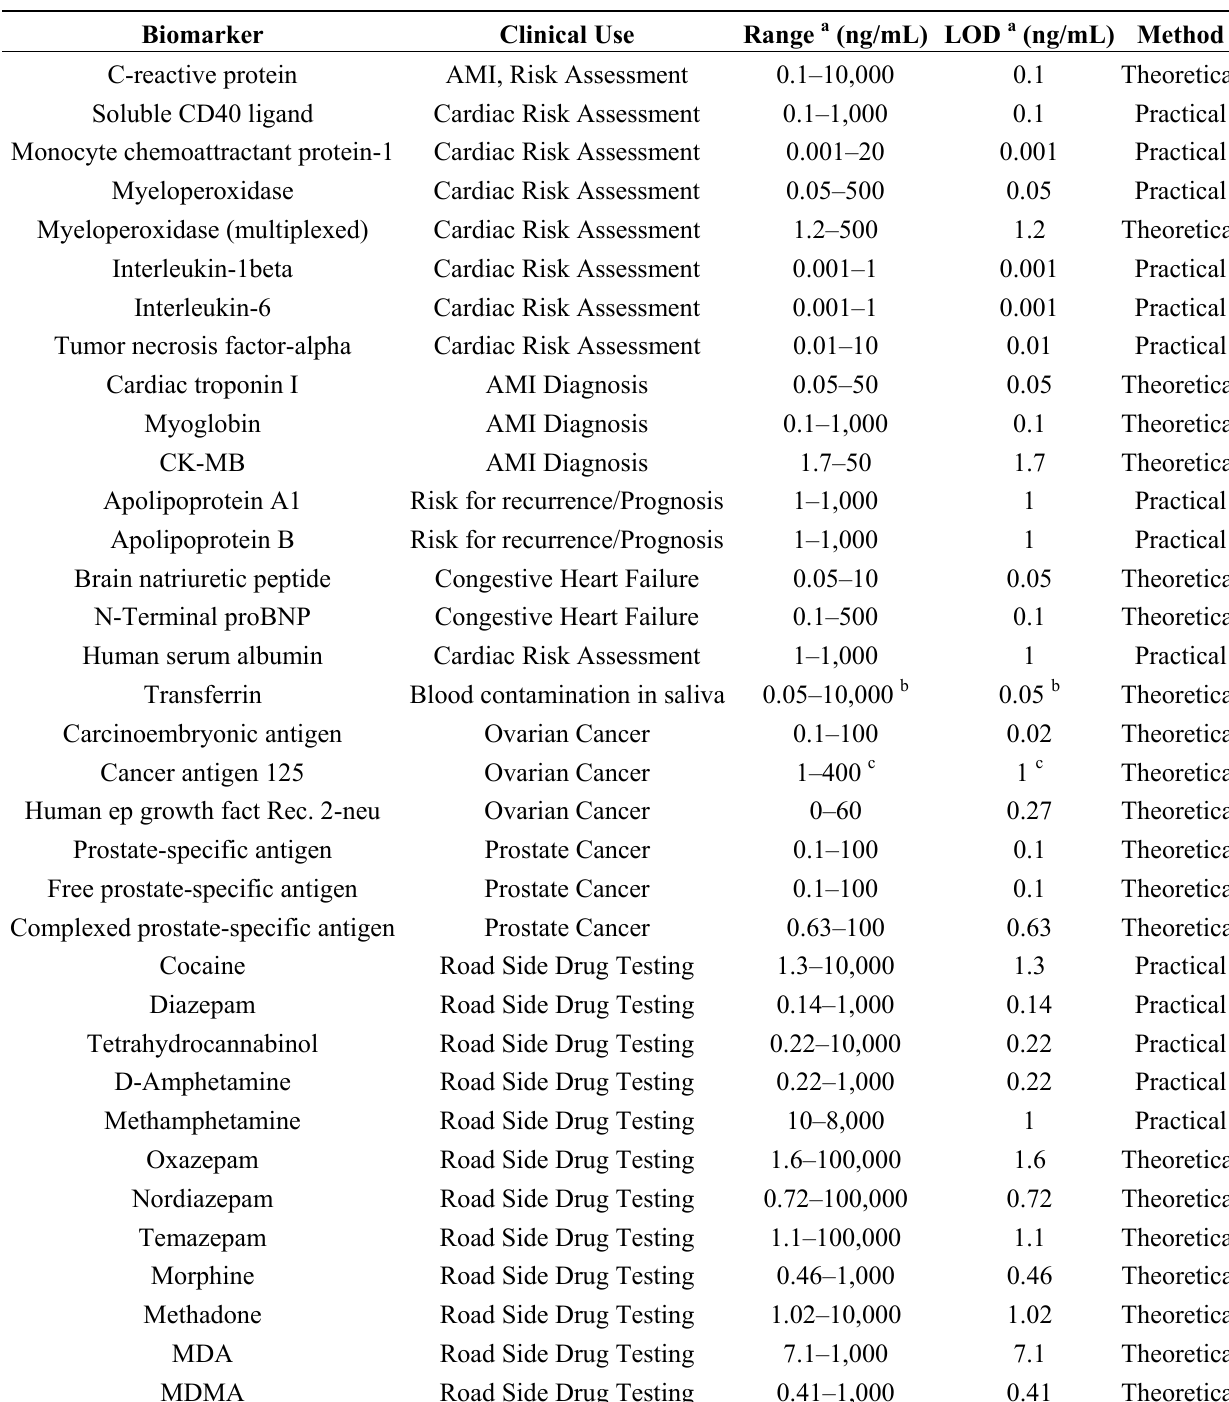
Table 2. Initial specifications obtained with laboratory-based p-BNC porous bead-based approach: List of developed biomarker assays, targeted use, and device performance characteristics in the context of real-world clinical